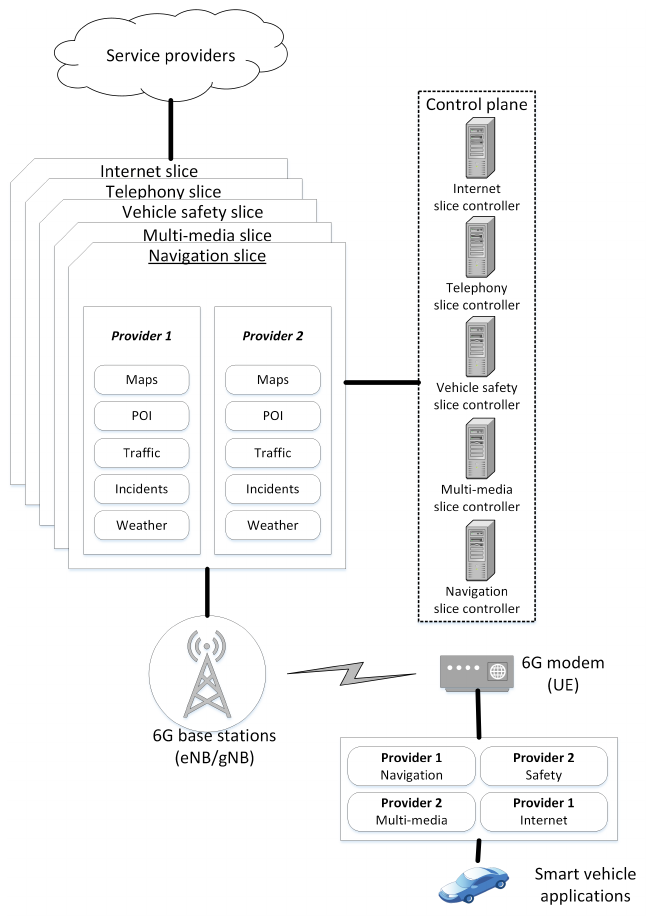
Figure A1. Example of smart vehicle multi-slice